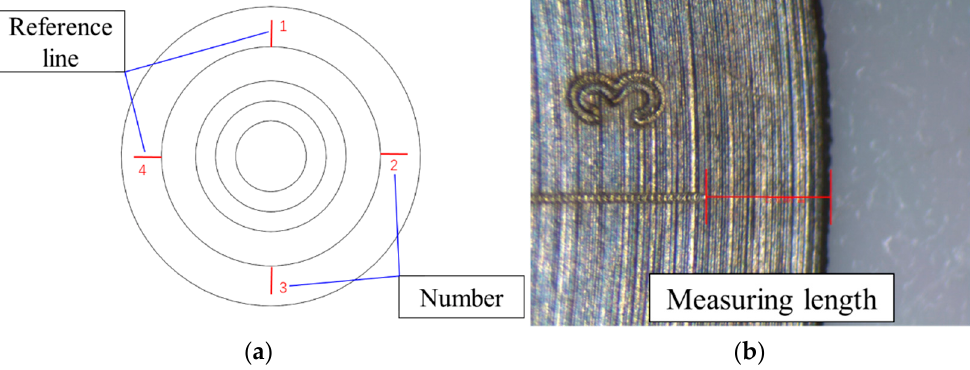
Figure 3. ( a ) Four places at 90° intervals; ( b ) Marks by laser etching.